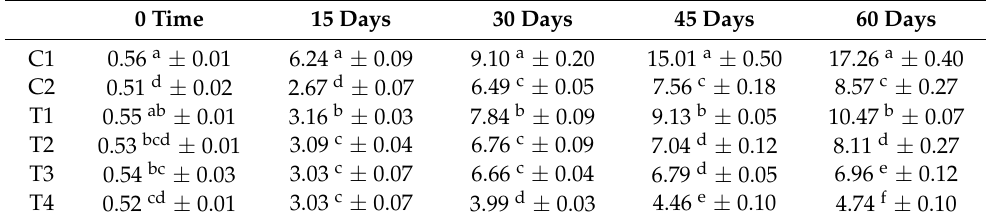
Table 8. Changes in peroxide value of mayonnaise samples enriched with RCFE during